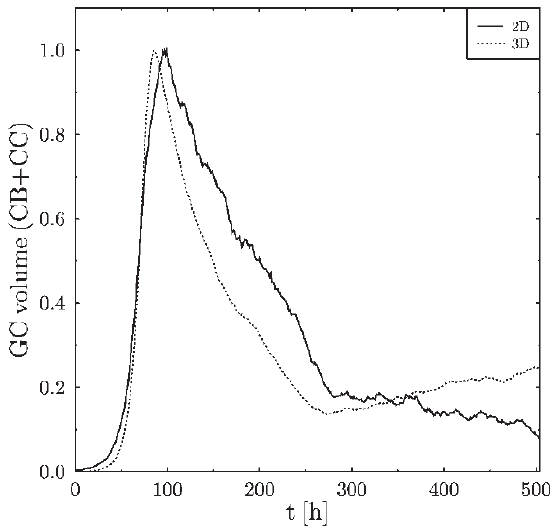
FIGURE 4 The time course of the GC volume: in order to compare both GC volume kinetics, each time course has been normalized to its maximum value. The 2D simulation reaches its maximum slightly later compared to the 3D simulation. This retardation is transported into the later phases of the GC reaction. The cell population declines less in the 3D simulation during the final phase of the GC reaction.